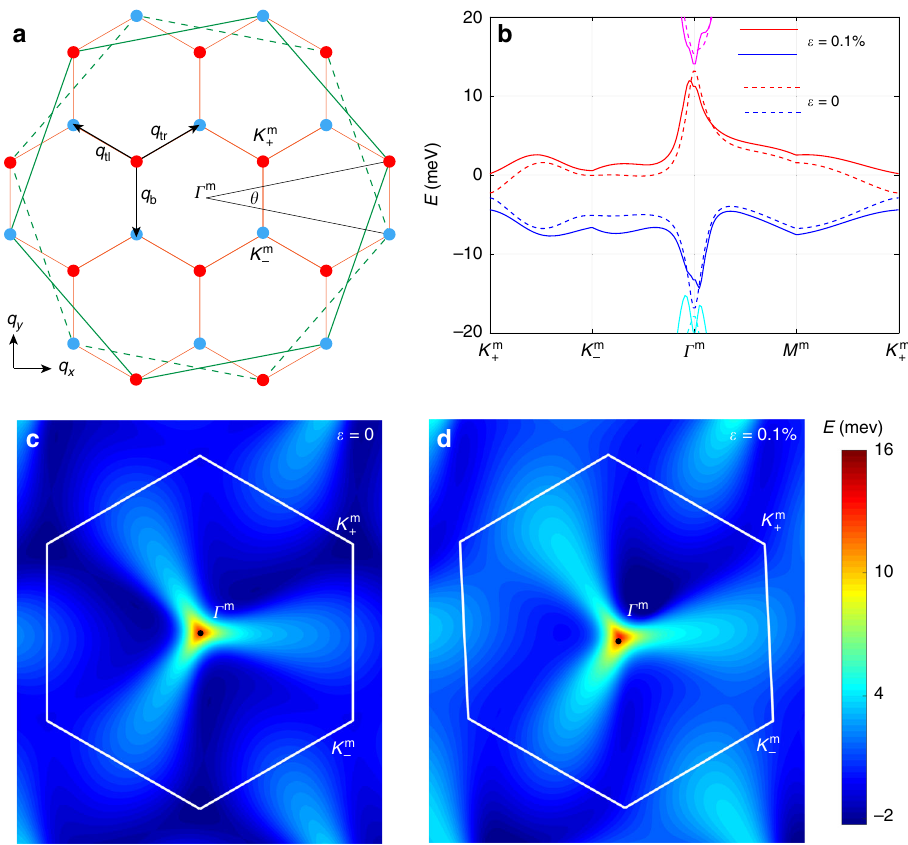
Fig. 1 The energy dispersion of TBG. a The original Brillouin zone is folded into the mini-Brillouin zone for the moiré superlattice. The solid and dashed green lines de fi ning the large hexagons represent the original Brillouin zones of the top and bottom graphene layers respectively. b The fl at bands energy dispersion from the K valley with the twist angle θ ¼ 1 : 2 (cid:5) . The dashed and solid lines are the cases with strain ε ¼ 0 and ε ¼ 0 : 1 % , respectively. The red and blue bands þ represent the conduction ν ¼ c ð Þ and valence ν ¼ v ð Þ bands, respectively. The conduction fl at band energy dispersion in the mini-Brillouin zone with strain ε ¼ 0 E for c and ε ¼ 0 : 1 % for d , respectively. The energy dispersion from the other valley K can be mapped by the time-reversal symmetry as E s ; s ; (cid:1) ; ν (cid:1) q ð Þ (cid:1) þ ; ν q ð Þ ¼ gapless Dirac points at K m bottom graphene layer Hamiltonian as in the mini-Brillouin zone. The energy ± dispersion with strain is depicted by the solid lines in Fig. 1b. The energy dispersion for the conduction band (the red band in Fig. 1b) in the whole Brillouin zone are shown in Fig. 1c and d for the unstrained and the strained cases, respectively. It is clear from k ð Þ with spin index s , Fig. 1c that the energy dispersion E s ; ξ ; ν valley index ξ , and band index ν in general respects the C (cid:8) 3 K ξ is de fi ned relative to the uniaxial strain- deformed Brillouin zone corner, and the staggered potential threefold rotational symmetry as shown in Fig. 1d, in which we introduced by the hBN substrate takes Δ ¼ 17 meV 45,46 . The set ε ¼ 0 : 1 % and the strain is applied along the direction of the symmetry and reduces D to D staggered potential breaks the C zig-zag edge of the bottom layer graphene ( ϕ ¼ 0 in Eq. (2)). 2 z 6 3 symmetry, while the uniaxial strain further removes all the crystal group. lattice symmetry and brings the TBG down to the C 1 Orbital magnetic moment in TBG . With the Hamiltonian in Denoting the interlayer coupling between the strained bottom q ð Þ and the Eq. (4), we can calculate the Berry curvature Ω z s ; ξ ; ν q ð Þ orbital magnetic moment in the out-of-plane direction m z s ; ξ ; ν of each Bloch state: